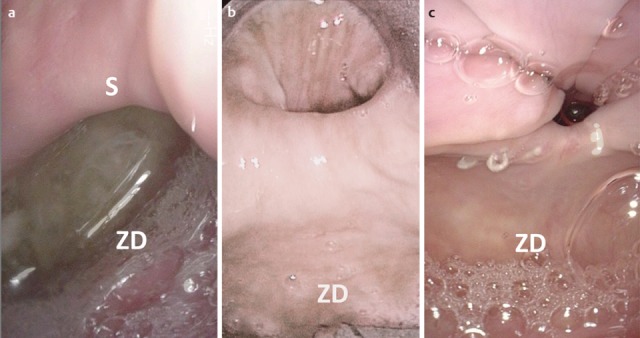
a – exposed entrance of Zenker’s diverticulum during flexible endoscopy; b – intraoperative view with diverticuloscope; c – 6 months after transoral endoscopic stapling, discrete residual diverticulum, the patient is free of complaints.